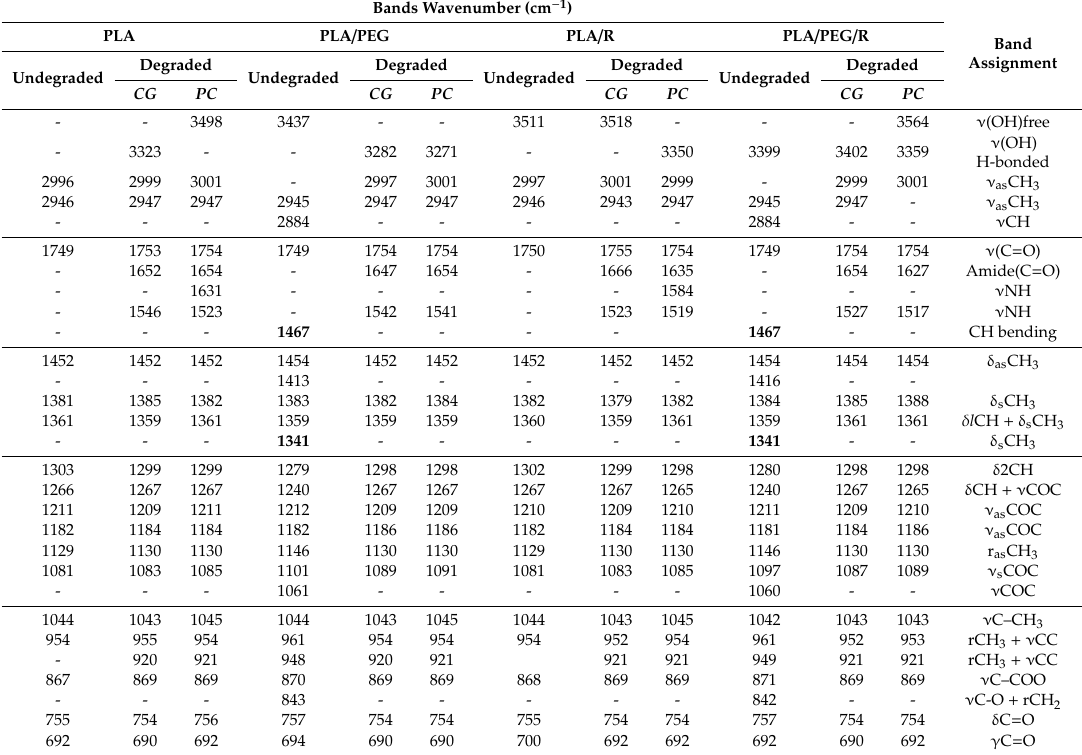
Table 4. FTIR spectroscopy data and the band